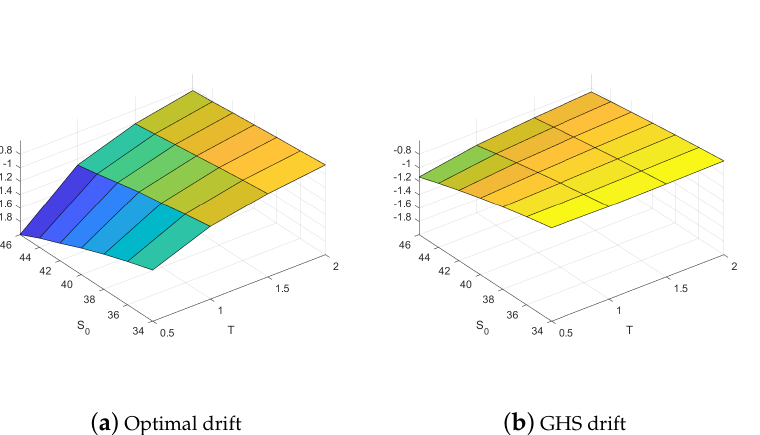
Figure 5. Optimal and GHS drift. Results from panel ( a ) show the estimated variance minimizing drift parameter for an FDM algorithm with N = 10 5 paths obtained from a gradient descent procedure. Results from panel ( b ) show the saddle point approximation of the variance minimizing drift parameter for a European put option following the methodology of Glasserman et al.